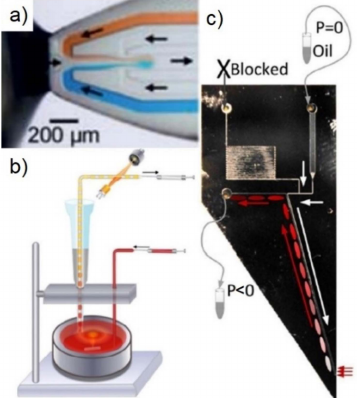
Figure 4. Methods that form droplets near the analyte source: ( a ) The middle channel is under negative pressure, sucking sample in through the device tip [97] (reprinted with permission. Copyright 2010 Royal Society of Chemistry); ( b ) droplet generated at the tip as co-flow. A Simple demonstration of sampling at the tip for 3-bromopropan-1-ol detection (reprinted with permission from Reference [98]. Copyright 2014 American Chemical Society); ( c ) sampling probe from Feng et al. which uses a microfabricated hydrophilic barrier (Reprinted with permission from Reference [69]. Copyright 2017 AIP Publishing